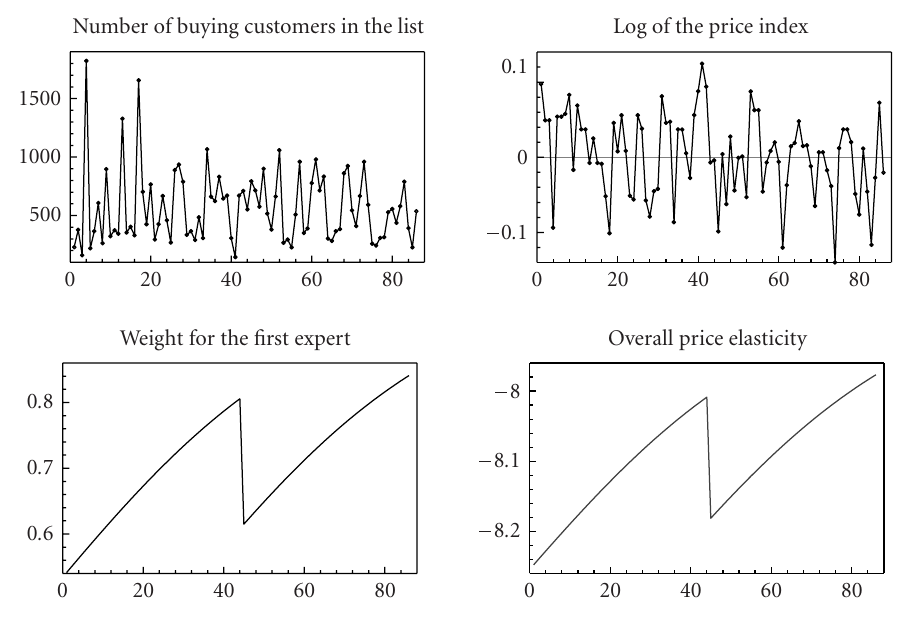
Figure 6.1. Mixture of 2 binomial